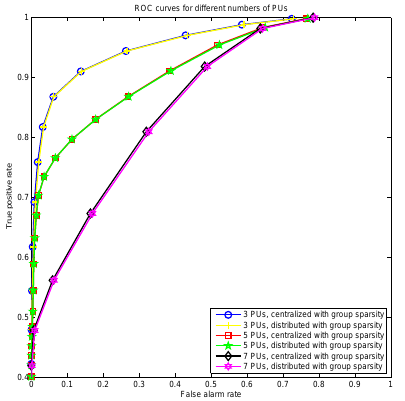
Figure 8. ROC curves at different sampling